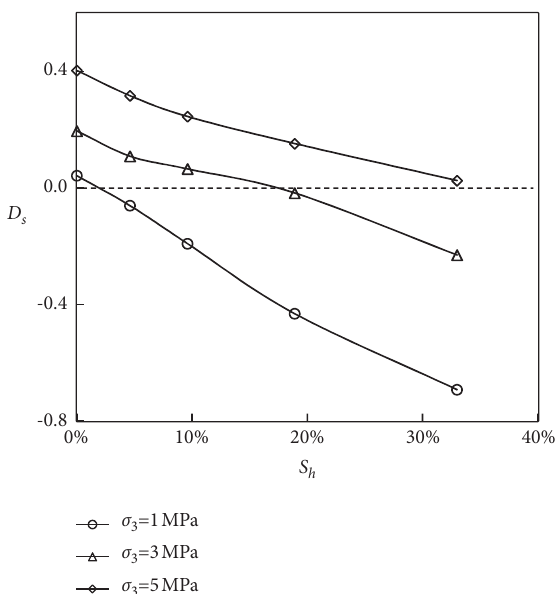
Figure 5: The relationship between the strain-softening index and hydrate